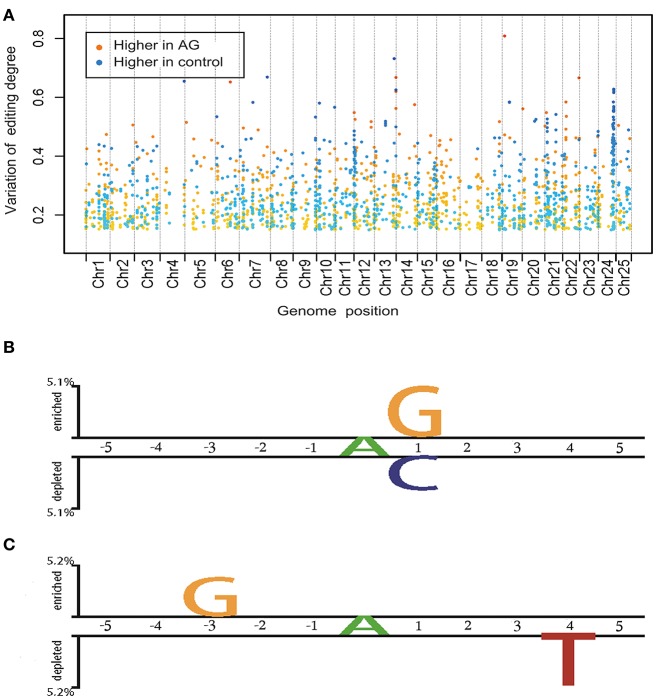
Global biological properties of editome in control and drug treated samples. (A) Distribution and fluctuation of whole editome under AG treatment. Each spot represents one editing site, of which the X-axis shows the location on chromosome and Y-axis shows the change of editing degree. Spots are highlighted in colors as follows: from yellow to red, editing degree higher in AG treatment; from green to blue, editing degree higher in wide type, the degree of color deepening was related to the change of editing degree. (B) Two sample logo of the differences between editing sites in high variation and low variation groups under drug treatment for the p-value threshold of 0.05. (C) Two sample logo of the differences between editing sites with higher editing degree in drug treated orwith higher editing degree in control groups for the p-value threshold of 0.05.